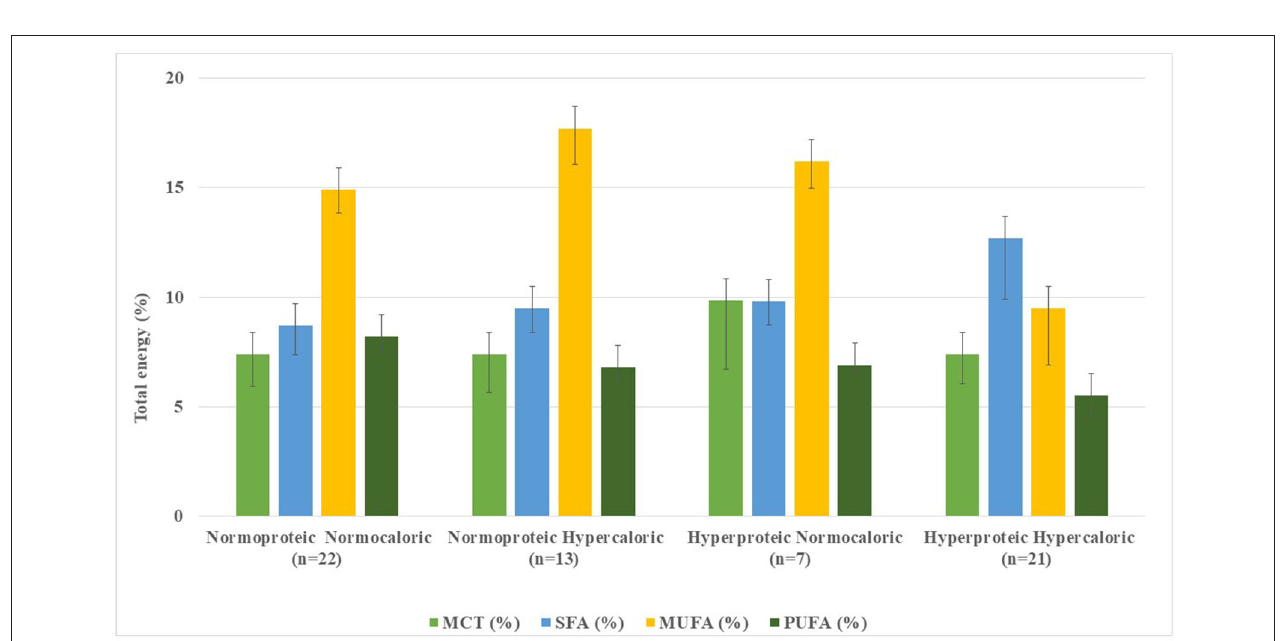
FIGURE 2 | Macronutrient distribution from standard enteral formula per 1,500 kcal infused. Enteral formulae were classified according to protein content and energy density into four groups (Gn), namely, Group 1, normoproteic normocaloric; Group 2, normoproteic hypercaloric; Group 3, hyperproteic normocaloric; and Group 4, hyperproteic-hypercaloric standard formula. The error bars on each bar show the minimum and maximum value of the nutrient analyzed per 1,500 kcal of standard enteral formulae.